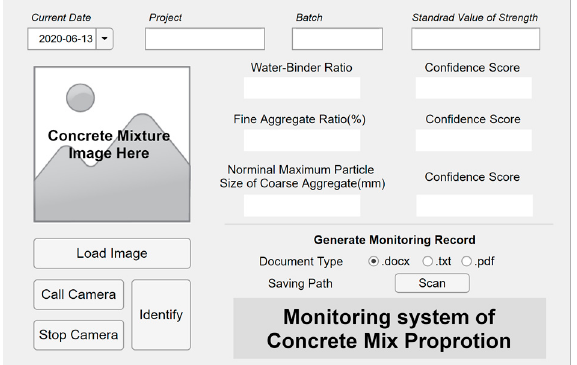
Figure 9. User interface of concrete mix proportion monitoring system.